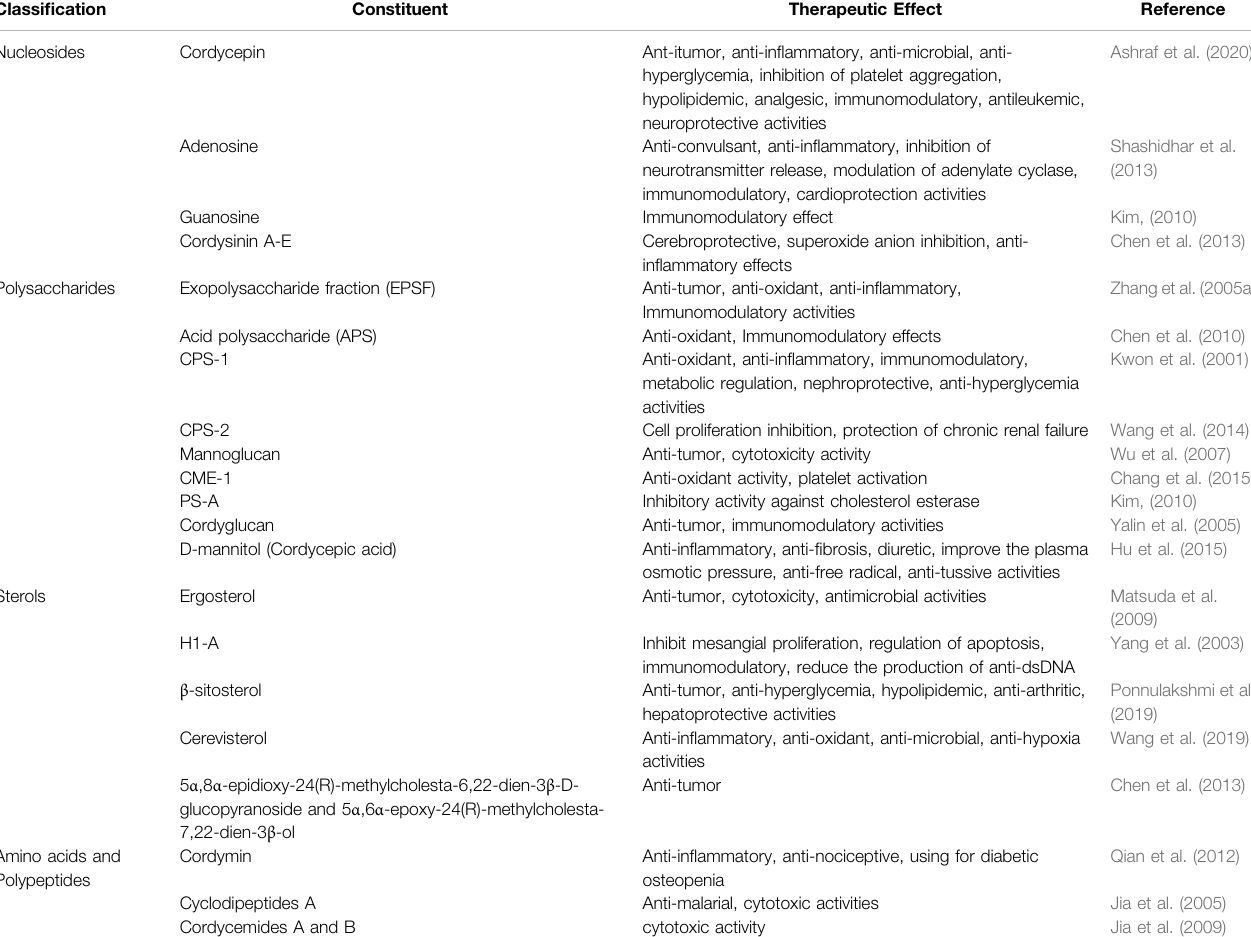
TABLE 1 | The main active extracts in Cordyceps